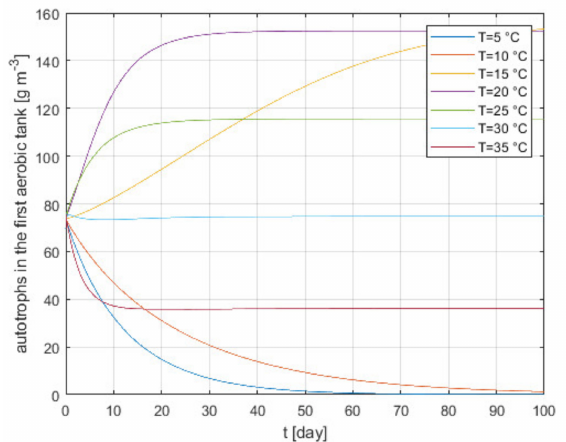
Figure 11. Dissolved oxygen ( a ) and ammonia nitrogen ( b ) in the first aerobic tank for di ff erent temperature values.